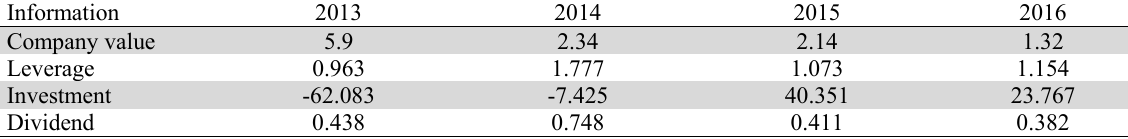
Average from company value, Leverage. Investment and dividend JII 2013-2016 Information 2013 2014